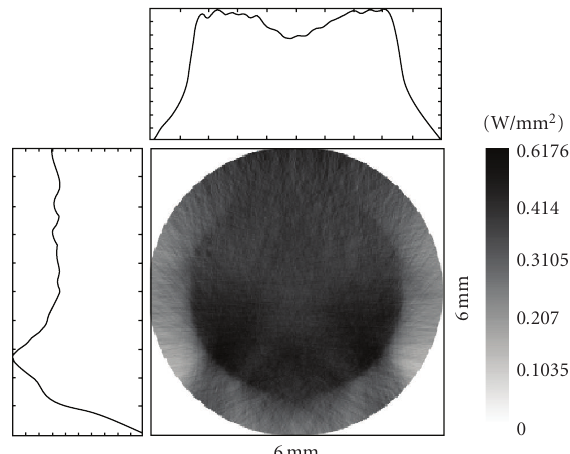
Figure 2: Gray-scale absorption distribution for the 6mm diameter Nd:YAG rod pumped by the 3D-CPC-2D-CPC cavity. Black signifies near or maximum absorption whereas white signifies little or no absorption (vertical unit in W/mm 2